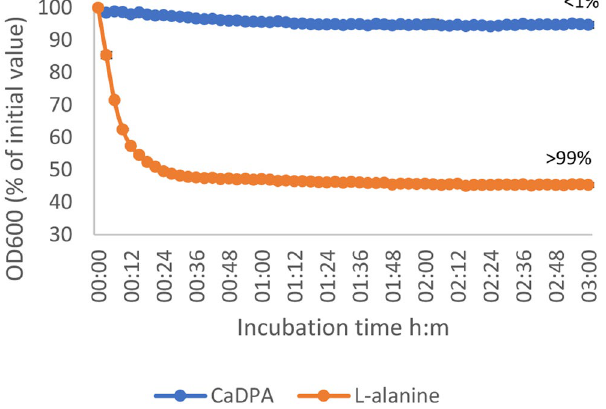
Figure 1. Effect of L-alanine (50 mM) and exogenous Ca 2 + -DPA (60 mM) on germination of C . botulinum Eklund 17B wild type spores. Data labels (right) refer to percentage germination observed by phase contrast microscopy at 3 hours. Error bars represent the standard deviation of 3 independent experiments.